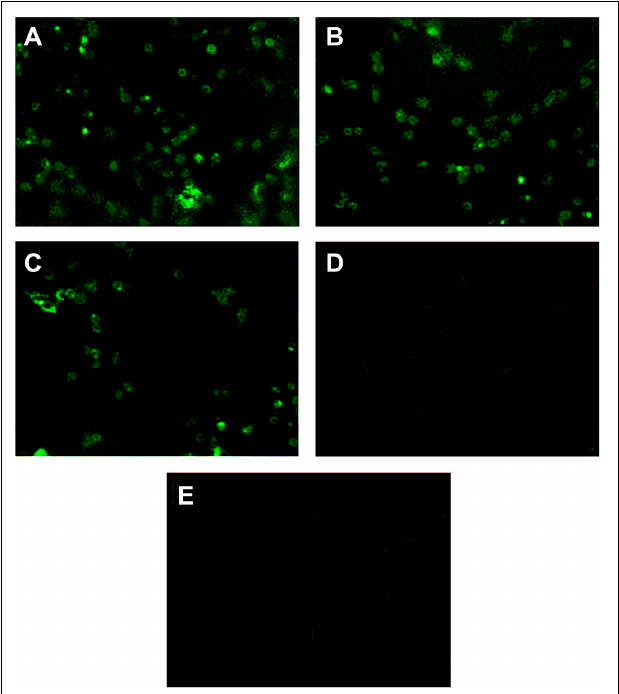
FIGURE 3 | The linked Fc and TPPPS adjuvant enhance phagocytosis of peritoneal macrophages. Initially, 5 µ g/mL ompA–Fc mixed with 50 µ g/mL TPPPS (A) , 5 µ g/mL ompA–Fc (B) , 5 µ g/mL ompA (C) , and 50 µ g/mL TPPPS (D) and 100 µ L PBS (E) were separately added into 96-well cell culture plates, where fresh peritoneal macrophages were cultured. After 6 h incubation, IFA was used to analyze the ompA phagocytosis, and the rat anti-omp polyclonal antibody as primary antibody and FITC-conjugated mouse anti-rat IgG as secondary antibody were incubated successively.